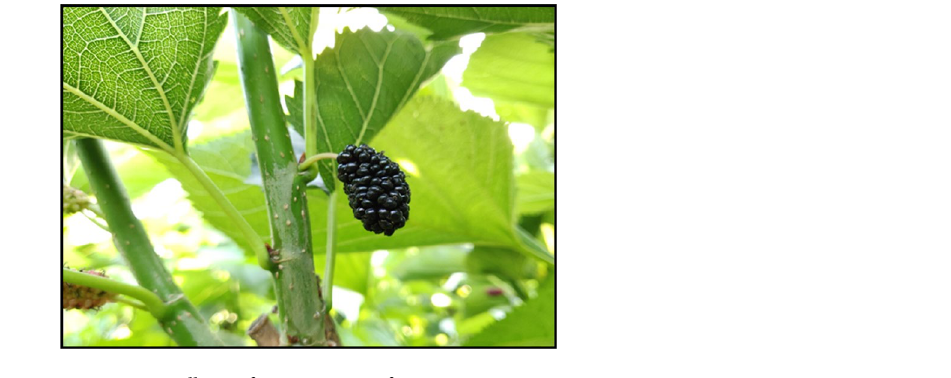
Figure 1. Mulberry fruit: a source of